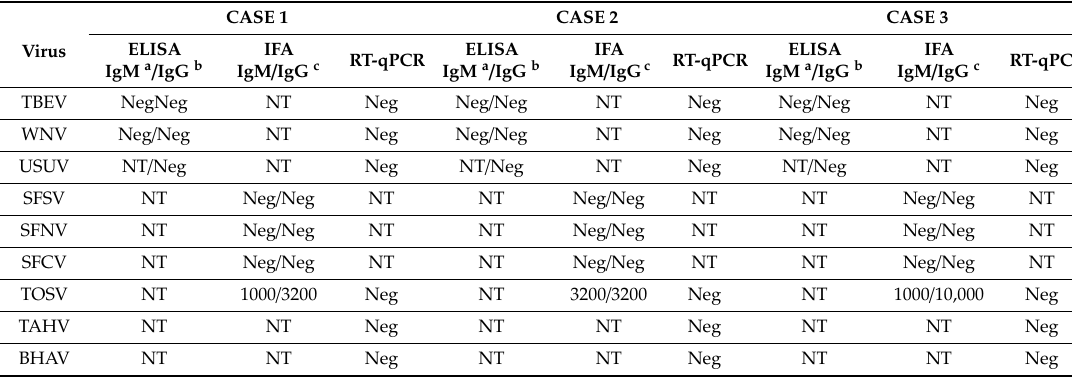
Table 2. Virology Results in Patients with Toscana Neuroinvasive